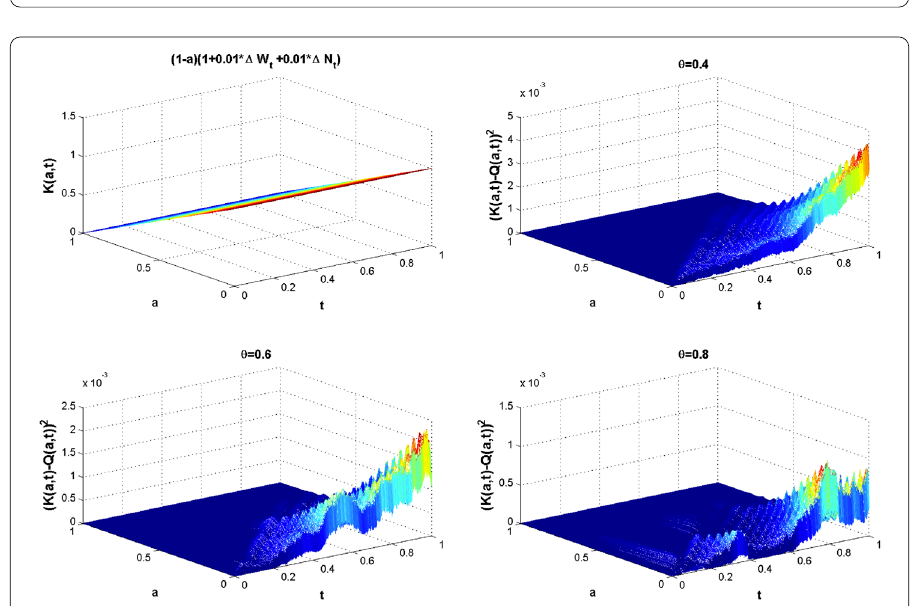
Figure 2 Error square simulation by the SS θ method with θ = 0.4,0.6,0.8 respectively for a stochastic age-dependent capital system with Poisson jumps and fBm ( H = 3